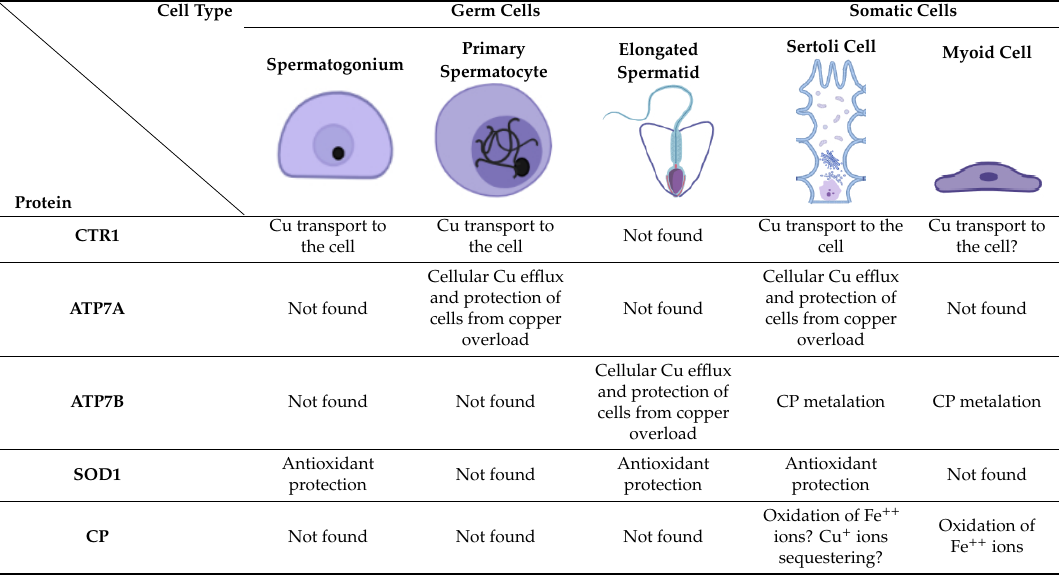
Table 1. The functions of copper-dependent proteins in the particular germ and somatic cells in the male mouse gonad.